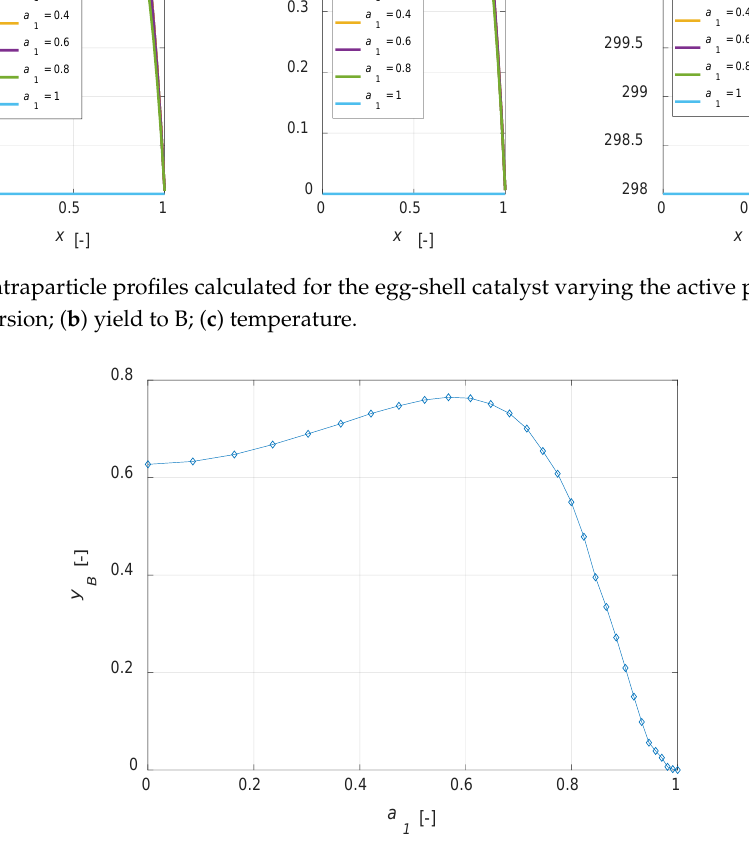
Figure 4. Intraparticle profiles calculated for the egg-shell catalyst varying the active phase content: ( a ) A conversion; ( b ) yield to B; ( c ) temperature.